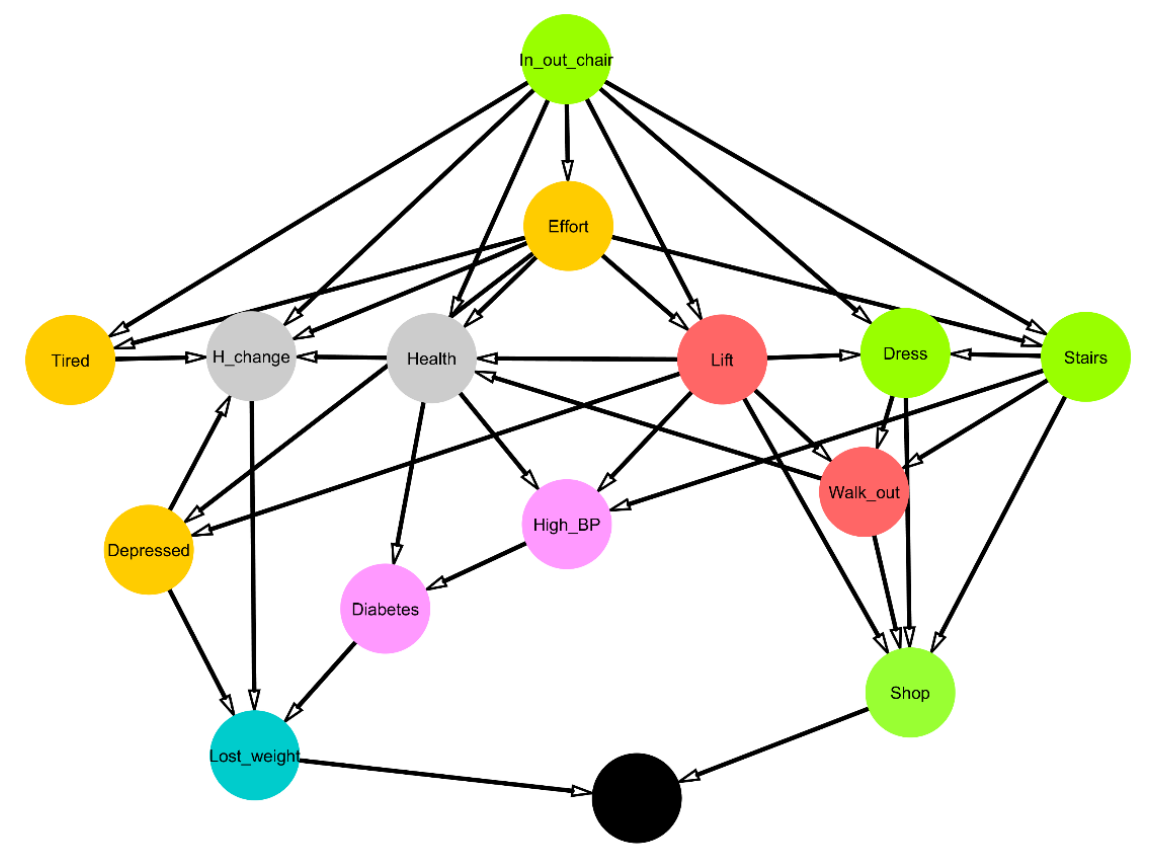
Figure 2. Directed graph induced by the set of ancestors of the Dead node (nodes from which there are directed paths to Dead ). Nodes are colored according to the following classification: black: Dead ; yellow: AS (Affective Status: Depressed, Tired, and Effort ); light blue: symptoms ( Lost_weight ); gray: SRH (Self-rated health: Health and H_change ); green: ADL-IADL (activities of daily living and Instrumental activities of daily living: In_out_chair, Stairs, Shop , and Dress ); orange: physical health ( Lift and Walk_out ); pink: comorbidities ( Diabetes and High_BP ).